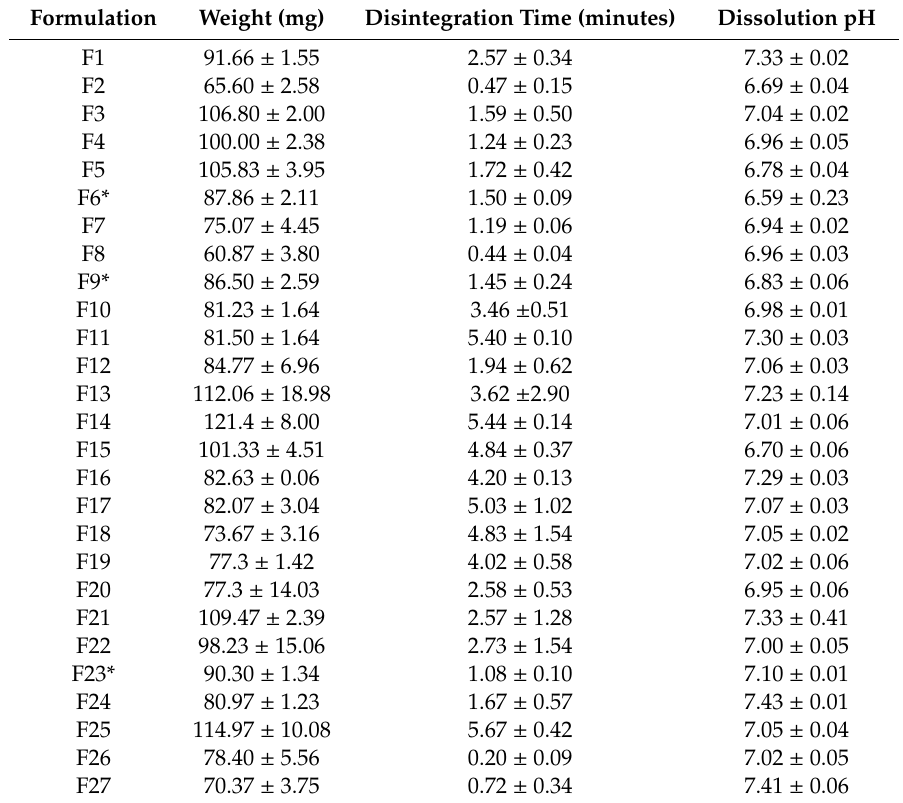
Table 1. Response parameters generated based on the quadratic experimental design